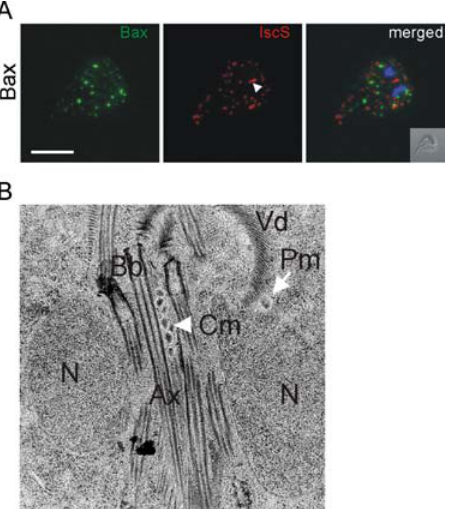
Figure 1. Expression of human Bax in induced Giardiatrophozoites does not affect mitosomes . A) Confocal microscopy analysis of the subcellular distribution of Bax in transgenic cells. Recombinant Bax (left panel, green) does not localize to mitosomes (middle panel, red) labeled with an anti-IscS rabbit antiserum as a mitosome marker. The signature central mitosome structure is indicated with an arrowhead. The merged images show a clear lack of co-localization. Nuclear DNA is stained with DAPI (blue). Inset: differential interference contrast (DIC) image. Scale bar: 5 m m. B) The central mitosome structure (Cm, arrowhead) is resolved as a tightly packed array of spherical organelles in electron microscopy of adherent cells. The subunits are indistinguish- able from individual peripheral mitosomes (Pm, arrow). This organelle structure is unchanged in transgenic trophozoites expressing Bax. N, nucleus; Bb, basal bodies; Ax, axonemes; Vd, ventral disk.